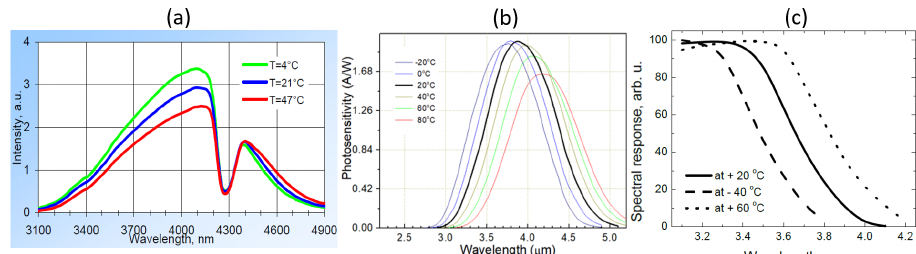
Figure 13. Temperature-dependence of the LED/photodiodes characteristics. ( a ) Emission spectrum of the LED. ( b ) Spectral response of the sensing photodiode. ( c ) Spectral response of the reference photodiode. Figures taken from [22], [23], [22],